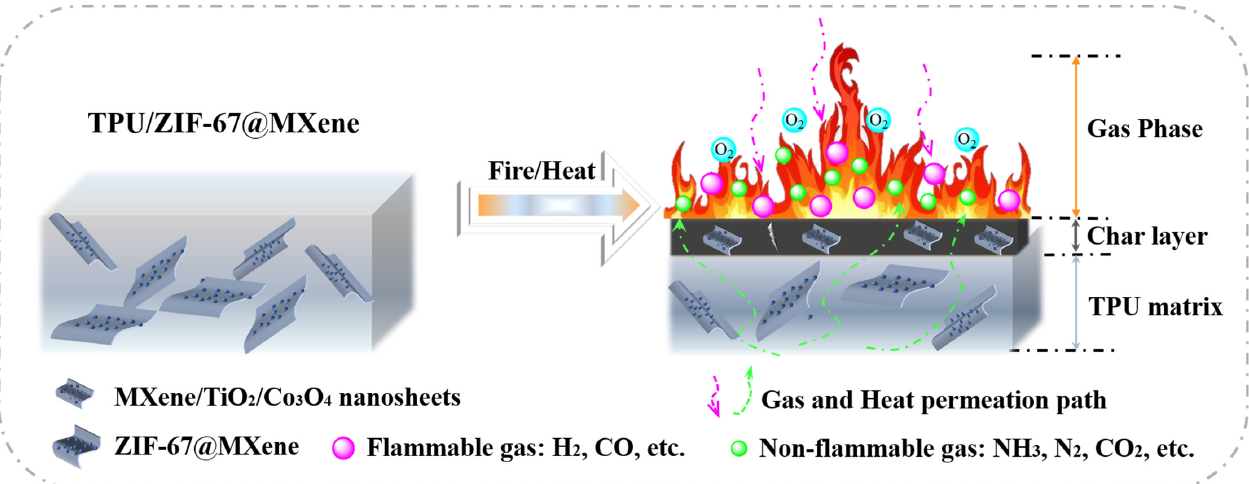
Figure 11. Possible flame-retardant mechanism of TPU/ZIF-67@MXene composites.